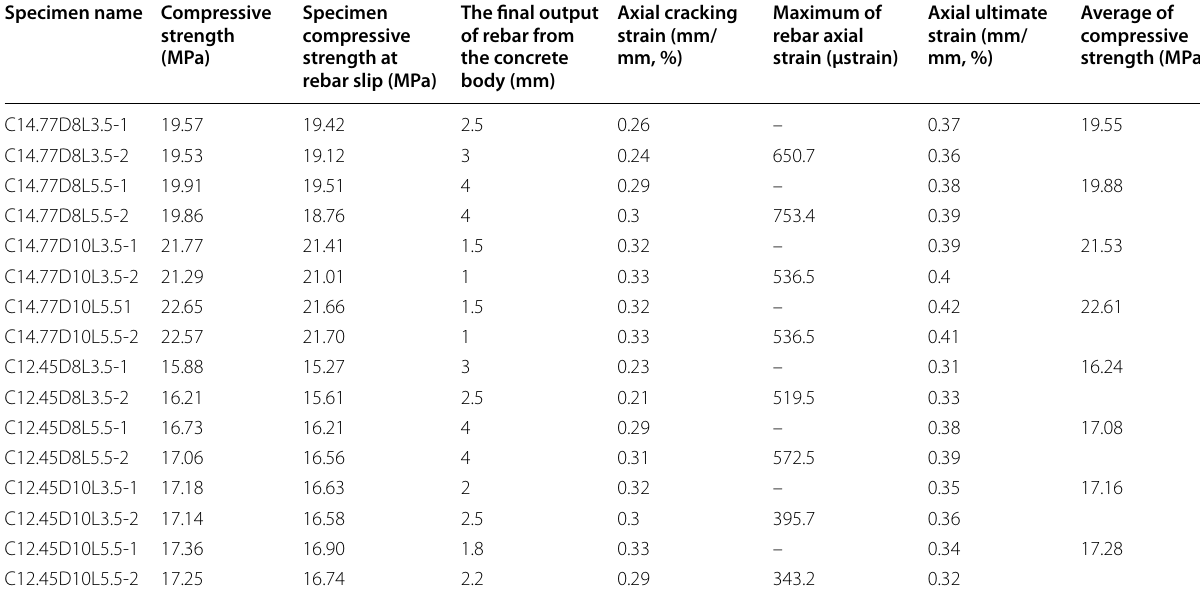
Table 7 Compressive strength test results of specimens embedded with steel